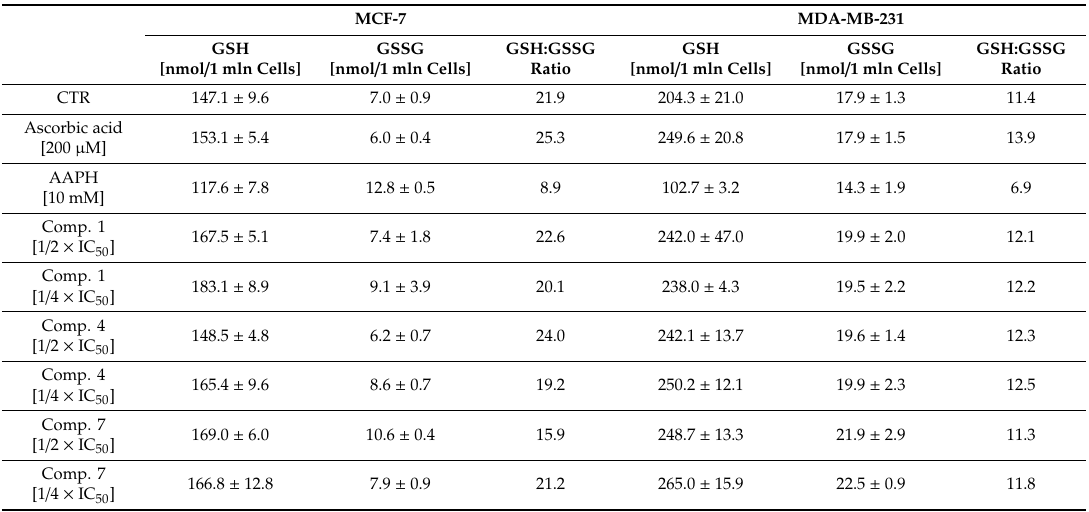
Table 6. The e ff ects of sulfonamides 1 , 4 and 7 on the intracellular GSH and GSSG concentrations. MCF-7 MDA-MB-231 GSH GSSG GSH:GSSG GSH [nmol / 1 mln Cells] [nmol / 1 mln Cells] Ratio [nmol / 1 mln